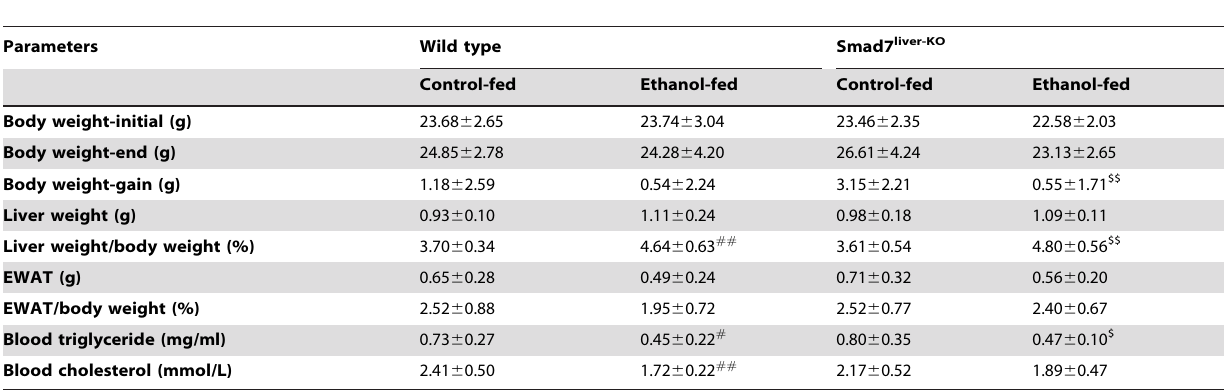
Table 1. Physiological and serum parameters of mice upon chronic-binge alcohol exposure.